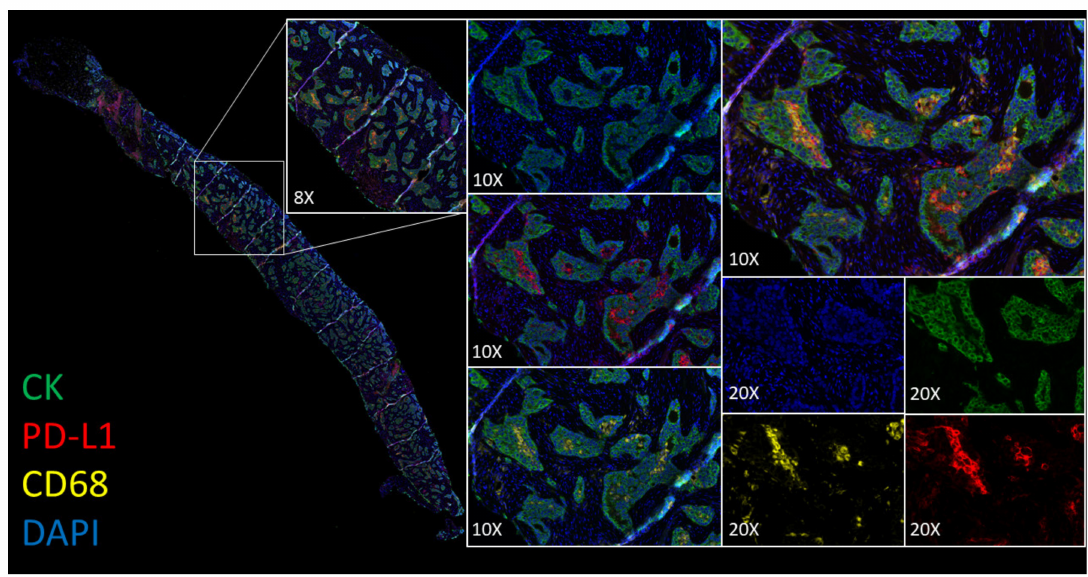
Figure 5. Utility of a PD-L1 multiplex on the assessment of a diagnostic case. Whole slide image of a strip biopsy with × 8 and × 10 magnifications of a region of interest. The × 10 magnifications show (top to bottom) DAPI / CK, DAPI / PD-L1, and DAPI / CD68. A × 20 magnification, inclusive of each individual channel of diagnostic interest, is shown on the right. Within distinct tumor beds, the majority of the positive cells are of a PD-L1 +/ CD68 + phenotype and are not PD-L1 +/ CK +